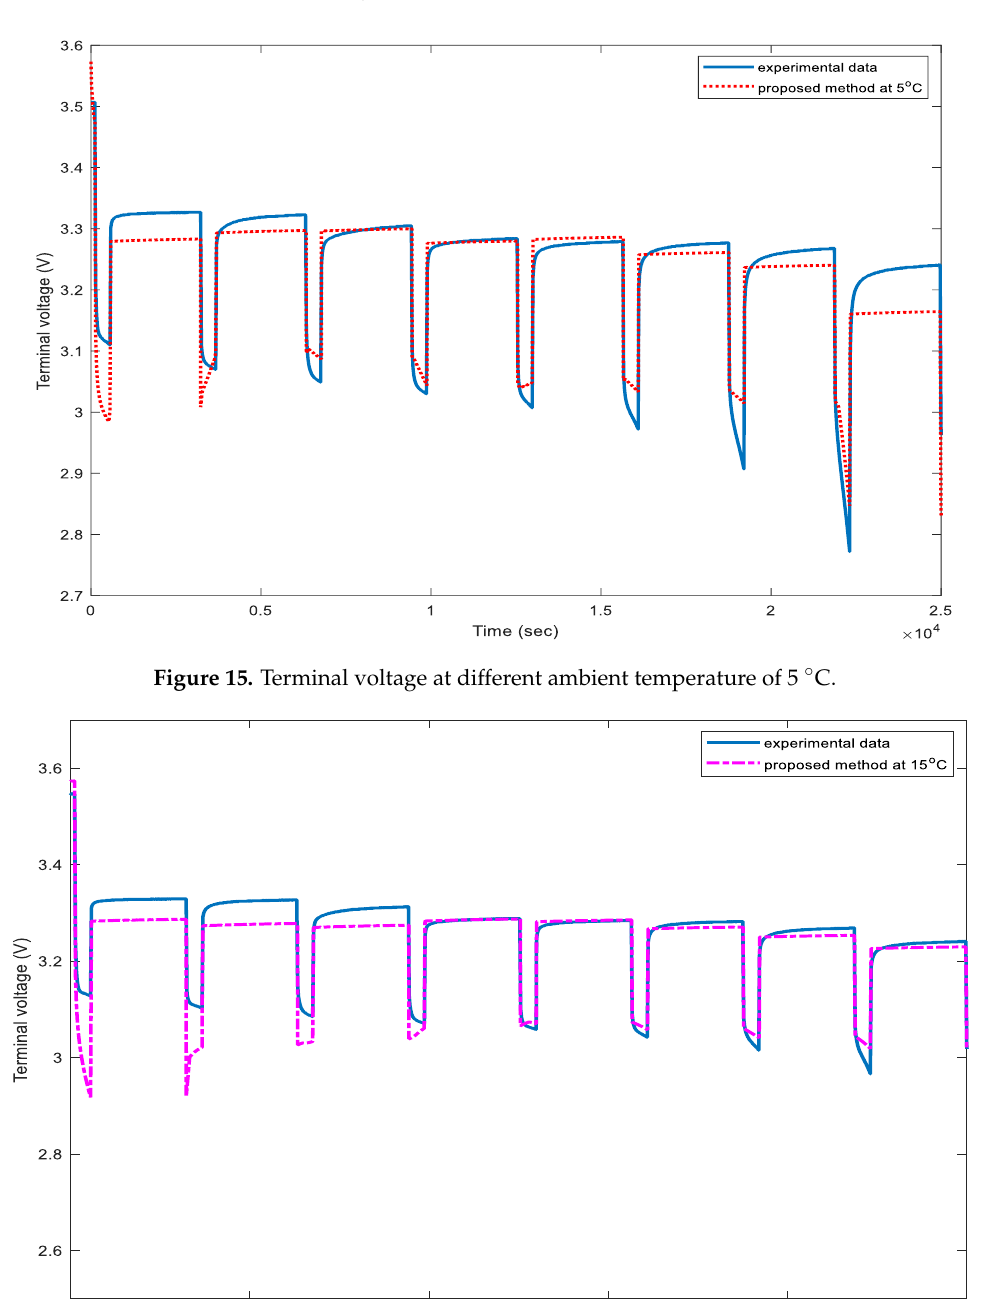
Figure 16. Terminal voltage at different ambient temperature of 15 °C.